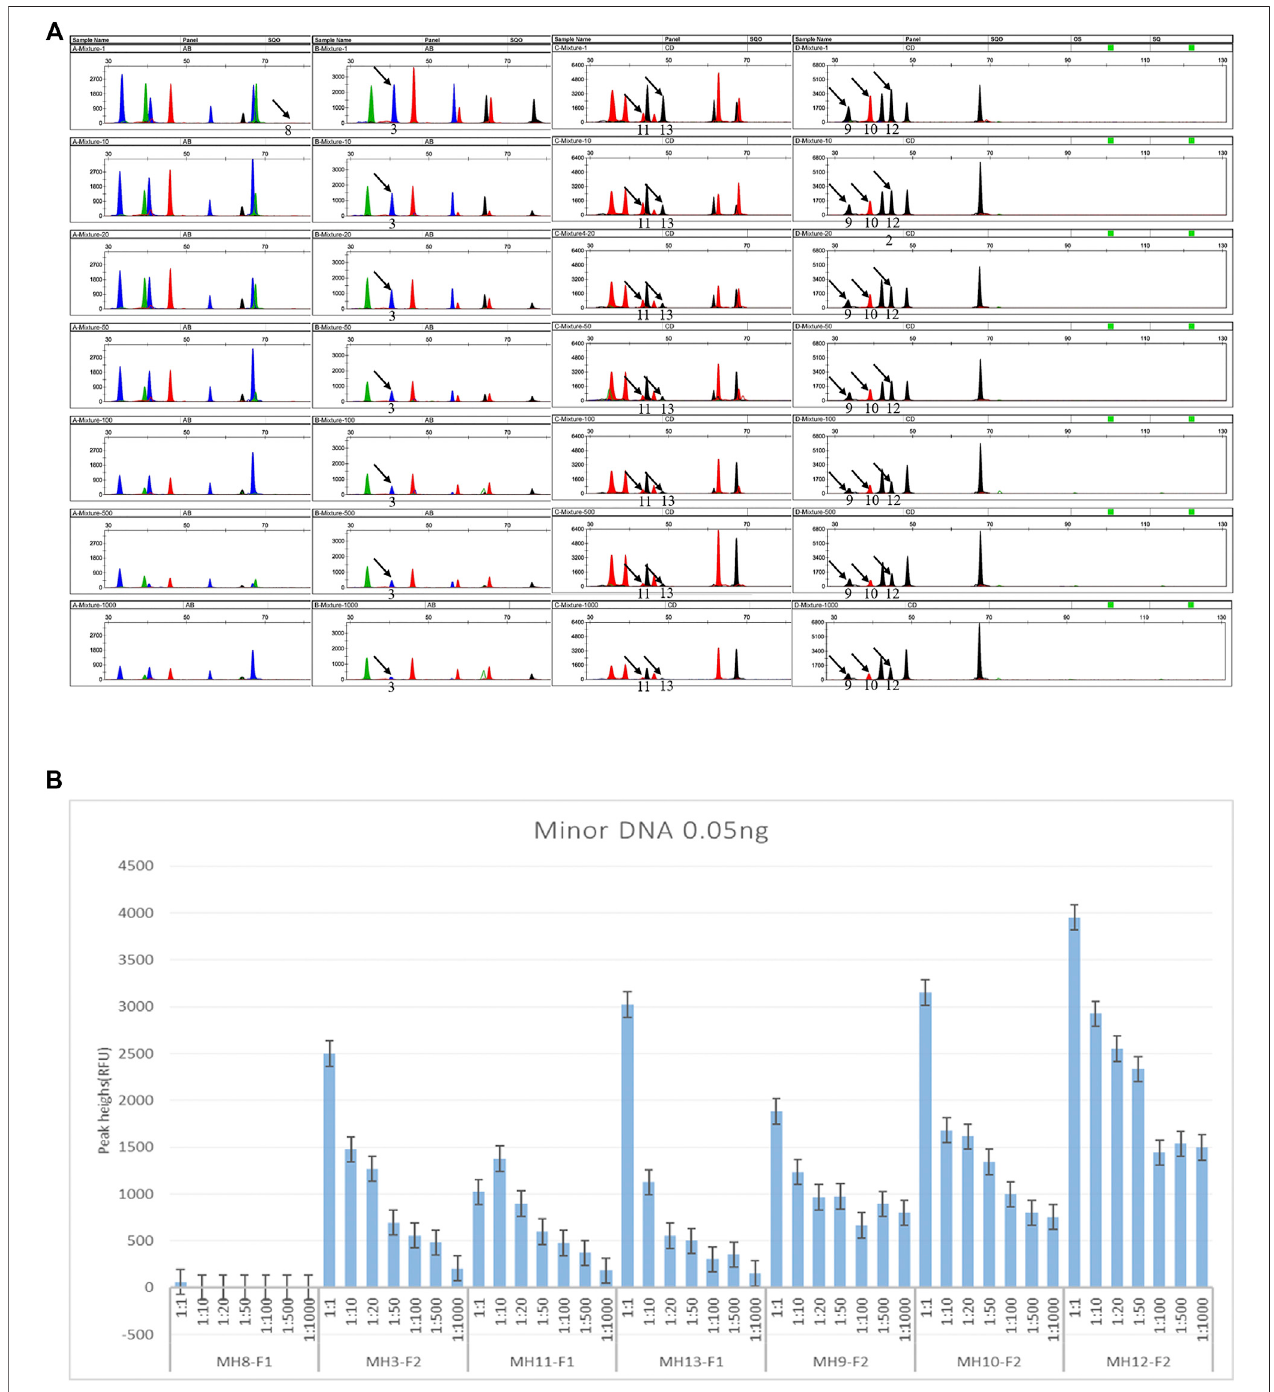
FIGURE 4 | Detection sensitivity of DNA mixtures (input amount 1 μ L). (A) Electropherograms ofthe mixture sensitivity. The simulated mixture was made from two randomly selected individuals. Seven loci were informative markers. For MH8, the minor DNA genotype is AA-CG, and the major is CG-CG. For MH3, the minor DNA genotypeisTC-TC,andthemajorisCC-CC.ForMH11,theminorDNAgenotypeisCA-TG,andthemajorisTG-TG.ForMH13,theminorDNAgenotypeisCG-TG,and the major is TG-TG. ForMH9, theminor DNA genotype isCA-TG, and themajor is CA-CA. ForMH10,the minor DNA genotype isCT-GT, and the major is CT-CT. For MH12, the minor DNA genotype is CG-TG, and the major is CG-CA. The black arrow indicates the informative allele of minor DNA. The detection ratio of minor DNA alleleswasashighas1:1,000.Astheratioincreased,thespeci fi cpeaksfromminorcontributorstendedtodecrease orevendisappear.Notethatastheratioincreased, the detection sensitivityof mixtures at the seven loci wasdifferent. Except for theminor speci fi c alleles (AA) at MH8, which were only detected in 1:1 (0.05 ng minor DNA and 0.05 ng major DNA), the minor speci fi c alleles at the remaining six loci could be detected in the 1:1,000 ratio. (B) Summary of the peak heights of the minor DNA informative markers in a series of dilutions. The homemade two-person mixture was diluted sequentially to 1:1, 1:10, 1:20, 1:50, 1:100, 1:500, and 1:1,000. The minor components were fi xed at 0.05 ng. Using the multiplex PCR-CE method, up to 1:1,000 minor DNA could be detected among the seven SNP-SNPs.